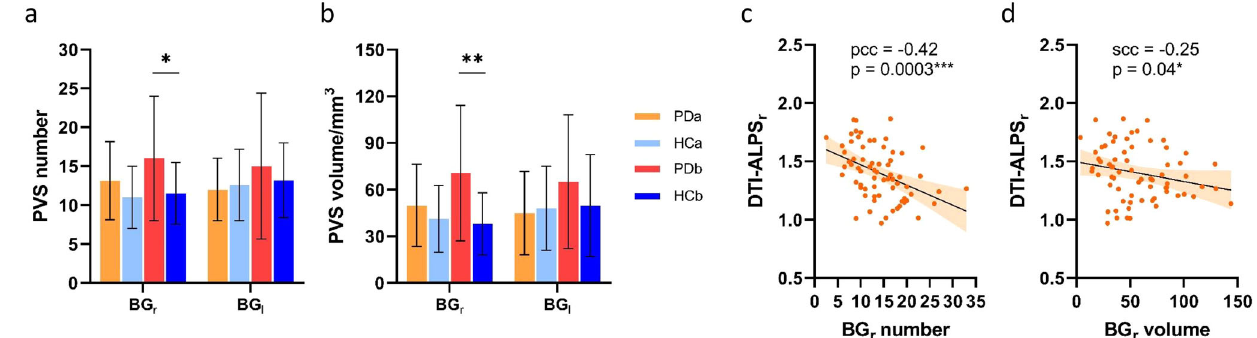
Fig. 2 Statistical analysis results of the PVS burden. Comparison of the PVS number ( a ) and volume ( b ) between the PD and HC groups. Correlations of right-hemispheric DTI-ALPS index with PVS number ( c ) and PVS volume ( d ) in right BG. The error bars represent the standard deviation. *indicates p value < 0.05, **indicates p value < 0.01; ***indicates p value < 0.001. PVS perivascular space, PD Parkinson ’ s disease, HC healthy control, PDa PD patients whose H&Y stage was lower than or equal to 2, PDb PD patients whose H&Y stage was higher than 2, DTI- ALPS r right-hemispheric diffusion tensor image analysis along the perivascular space, BG r right-hemispheric basal ganglia, scc Spearman correlation coef fi cient.